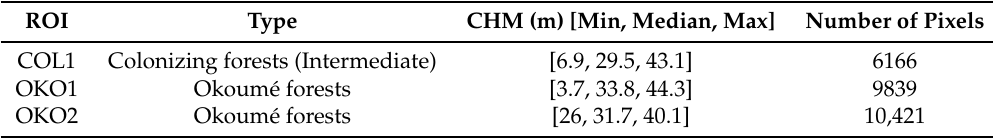
Table 1. Regions of interest (ROIs) at Lopé Park. CHM: canopy height model.